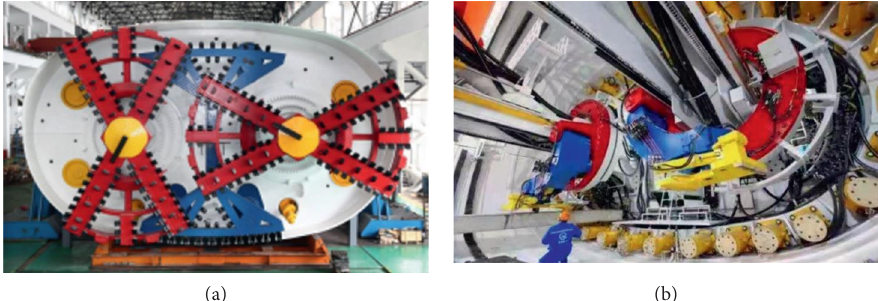
Figure 2: Quasi-rectangular earth pressure balance pipe jacking/shield dual-mode tunnelling machine: (a) The cutter head of dual-mode tunnelling machine. (b) Reformed shield segment assembly machine (pipe jacking machine mode without segment assembly machine).